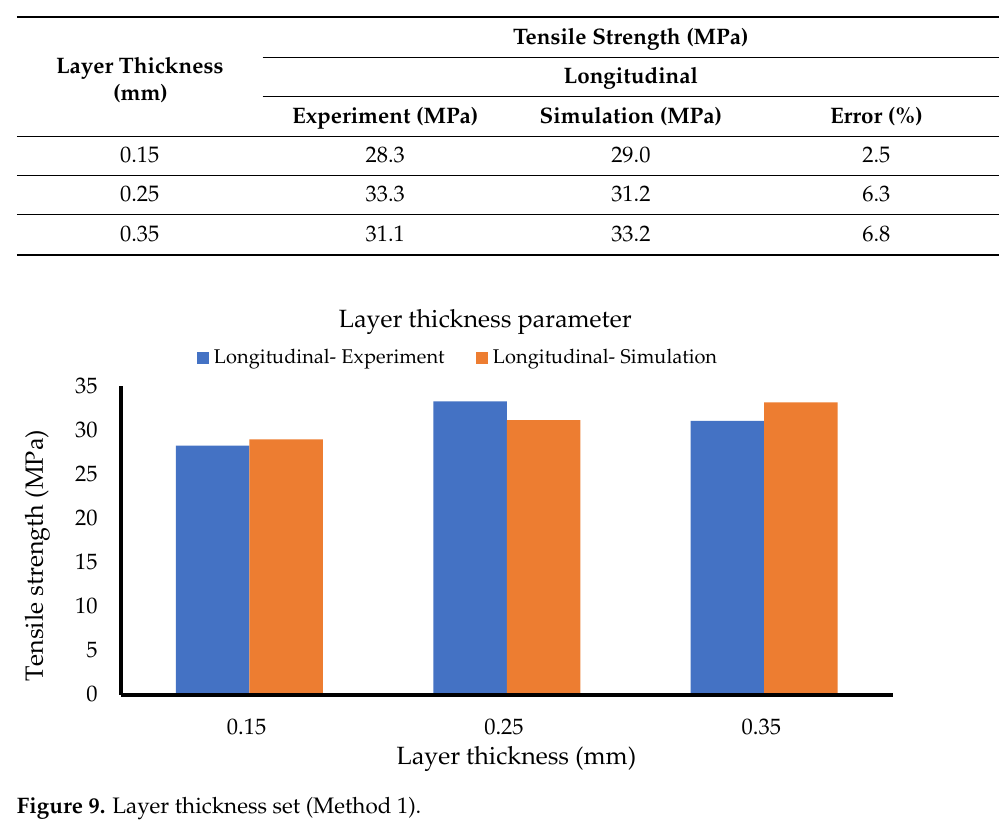
Figure 8. Infill density set (Method 1).